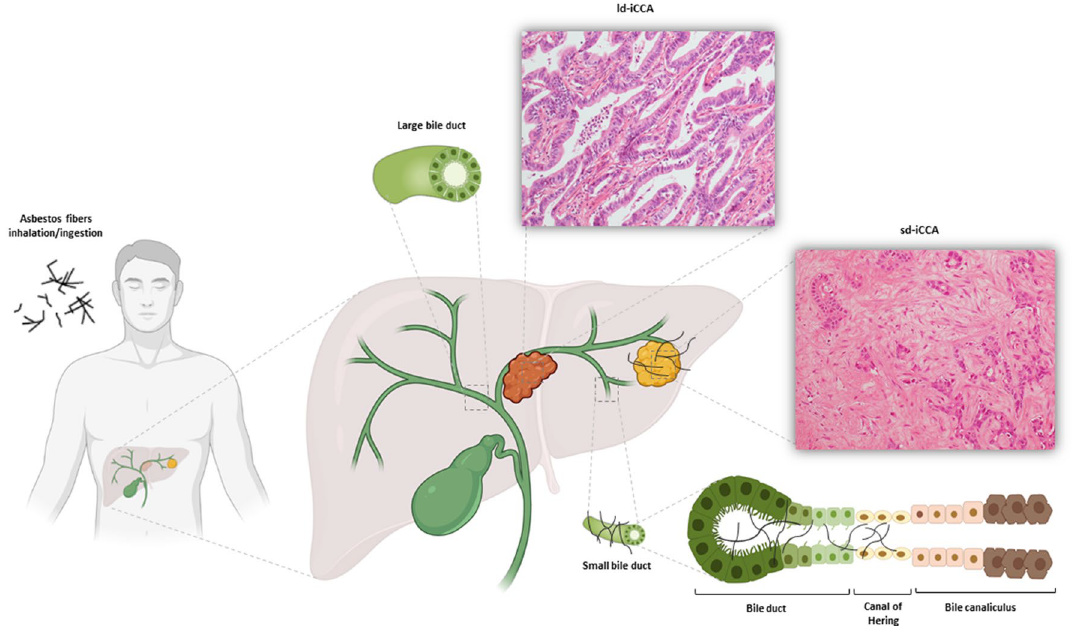
Figure 1. Schematic picture of the relationship between asbestos exposure and small duct iCCA. Highly- penetrant asbestos fibers—deriving from inhalation or ingestion reach the deepest liver parenchyma through the blood stream, up to the Hering’s channels and the terminal bile ductules, giving rise to iCCA with small duct morphology. Large ducts are not included in this